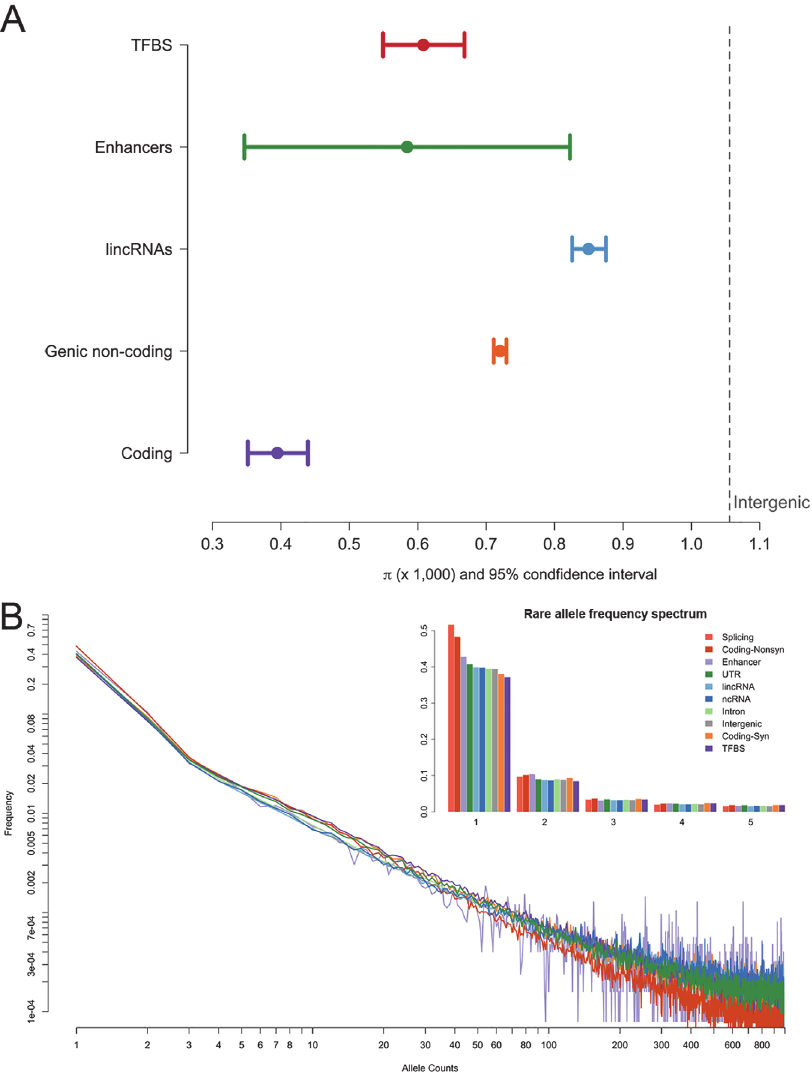
Fig 2. Genetic diversity across functional categories in the CHARGE-S participants. A is the distribution of nucleotide diversity across different categories of non-coding regions. B presents the frequency spectra of the minor allele in the studied population. The x -axis is the number of minor alleles in each non-coding category and the y -axis is the frequency of the chromosomes that carry that